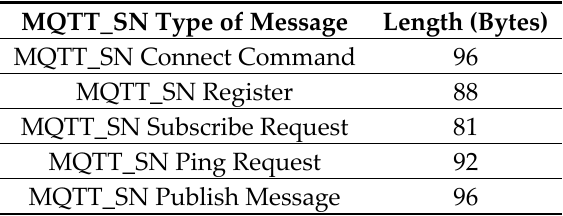
Figure 7. CoAP exchanged messages during the simulation. Table 2. MQTT_SN messages exchanged and its length.